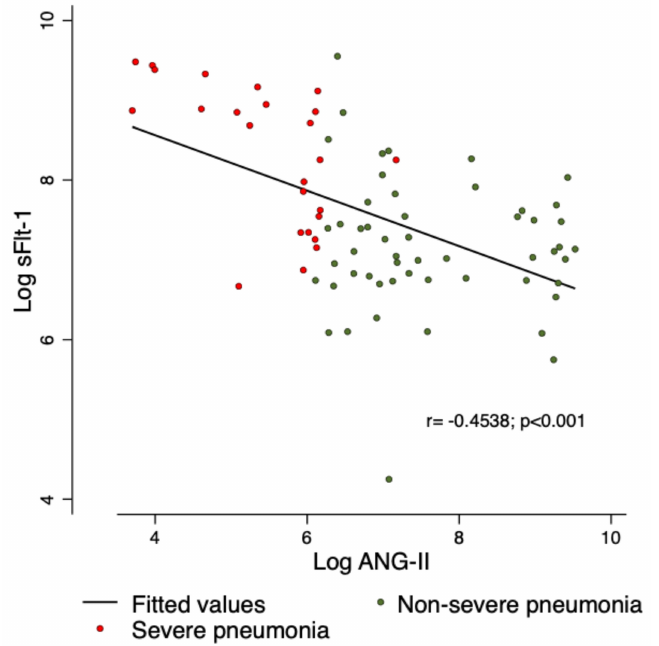
Figure 1. Relationship of sFlt-1 and ANG-II. A significant negative correlation was identified, between lower plasma concentrations of ANG-II, and very high plasma concentrations of sFlt-1.